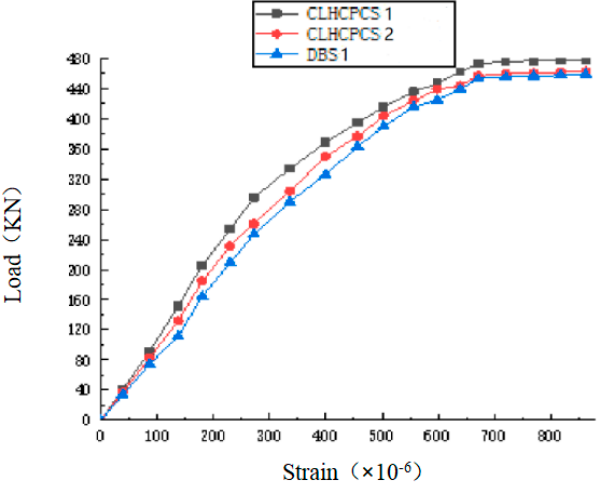
Figure 20. Load − strain curve of CLHCPCS reinforcement.